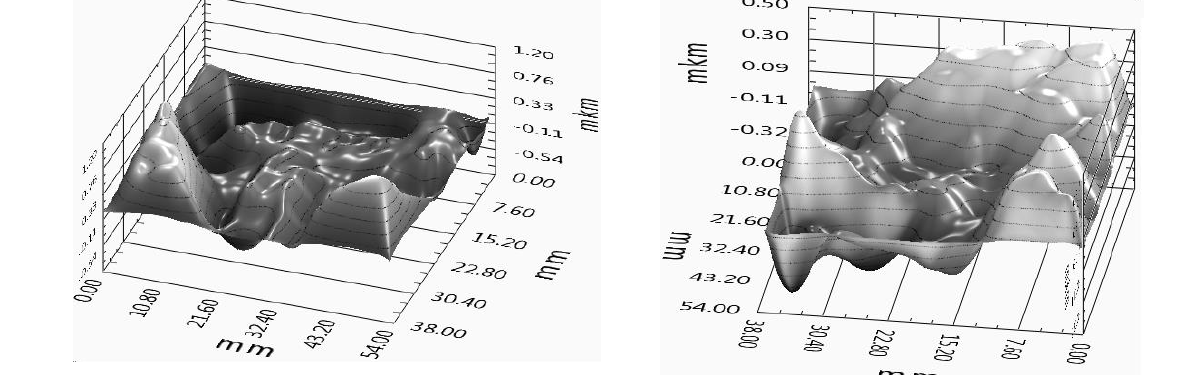
Figure 4. Deformation profile of epoxy poured clay.